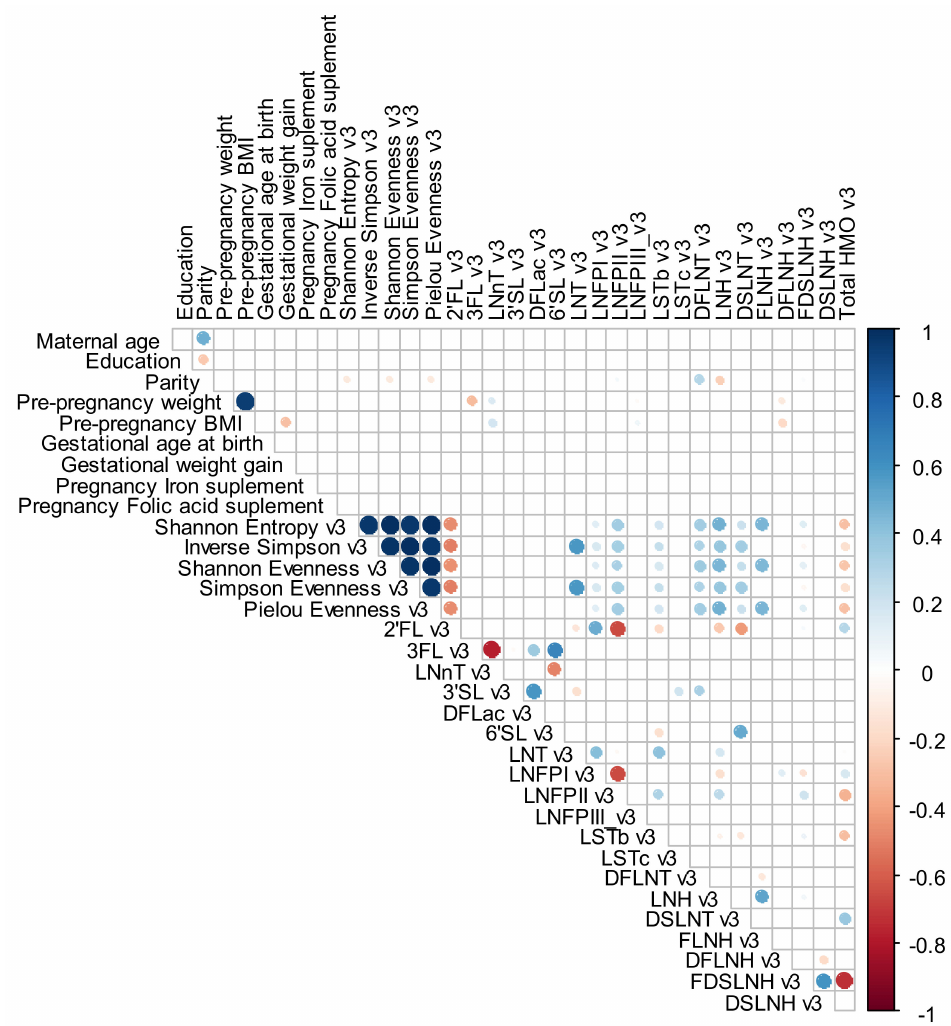
Figure 6. Spearman rank correlations between maternal demographic, anthropometric, reproductive and supplementary variables and individual HMO concentration in mmol / L and diversity and evenness at 88–119 days. The circle only becomes visible for the correlations that present a level of significance ≤ 0.01. The blue color indicates a positive and the red color a negative correlation. BMI: body mass index; DFLac, difucosyllactose; DFLNH, difucosyllacto-N-hexaose; DFLNT, difucosyllacto-N-tetrose; DSLNH, disialyllacto-N-hexaose; DSLNT, disialyllacto-N-tetraose; FDSLNH, fucodisialyllacto-N-hexaose; FLNH, fucosyllacto-N-hexaose; HMO, human milk oligosaccharide; LNFP, lacto-N-fucopentaose; LNH, lacto-N-hexaose; LNnT, lacto-N-neotetraose; LNT, lacto-N-tetrose; LSTb, sialyl-lacto-N-tetraose b; LSTc, sialyl-lacto-N-tetraose c; 2 (cid:48) FL, 2 (cid:48) -fucosyllactose; 3FL, 3-fucosyllactose; 3 (cid:48) SL, 3 (cid:48) -sialyllactose; 6 (cid:48) SL, 6 (cid:48)